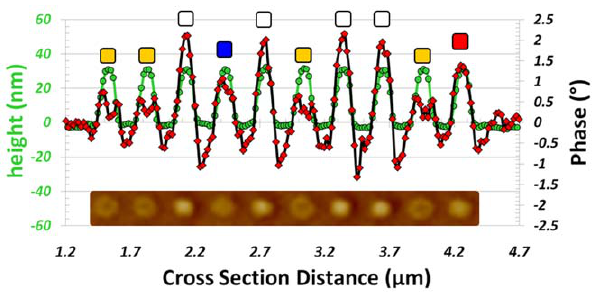
Figure 10. Quantification of ML MFM signals. AFM/MFM section line analysis of the row of nanopillars located between the black arrows in Figure 8. The colored squares represent the different magnetic states as shown in Figure 1. The inset is a cropped section of the MFM image, taken between the two black arrows.